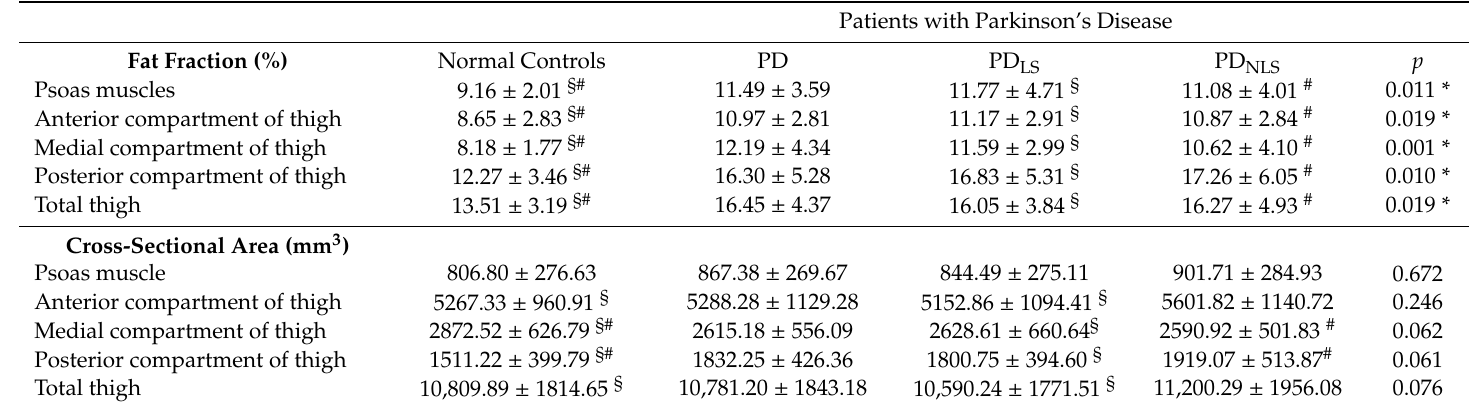
Table 2. A fat fraction and cross-sectional areas (mm 3 ) of bilateral psoas muscles and thigh muscles in PD patients and normal controls.